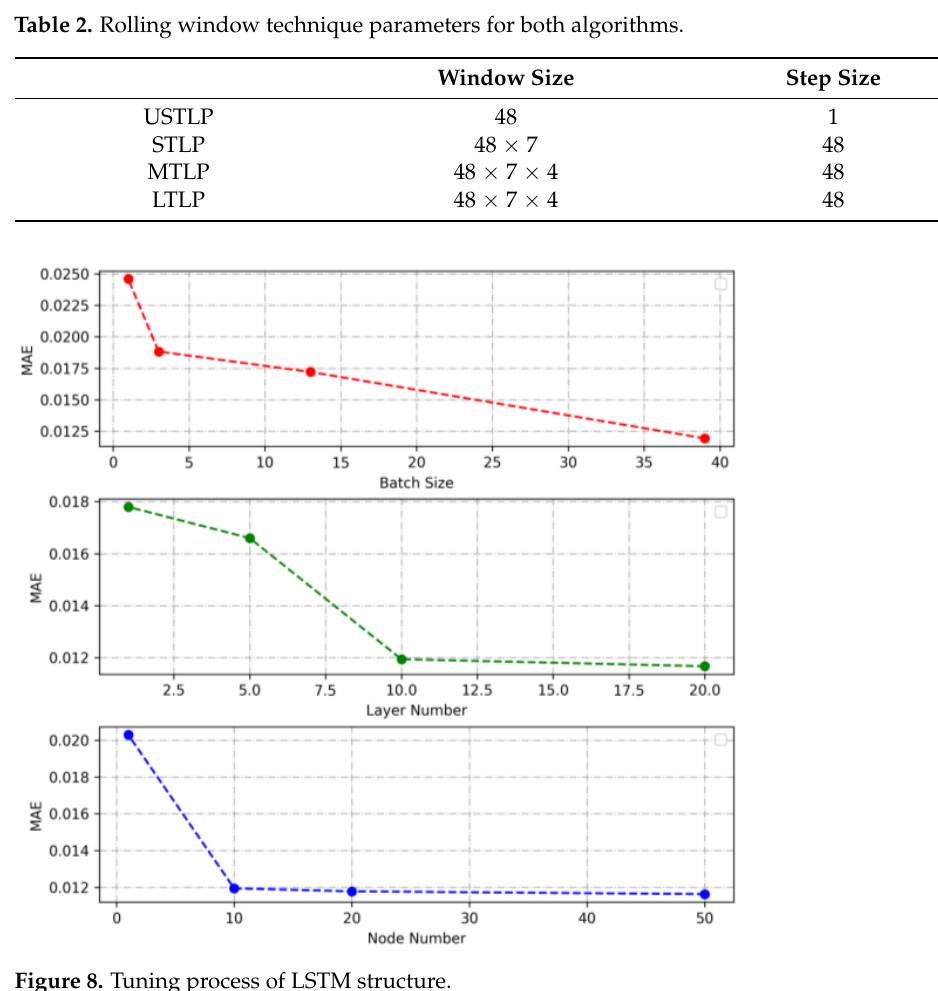
Figure 9. Tuning process of SVM hyperparameters. The rolling window technique is adopted in this paper for well-trained models. The parameters of rolling window techniques are demonstrated in Table 2. Table 2. Rolling window technique parameters for both algorithms. Window Size